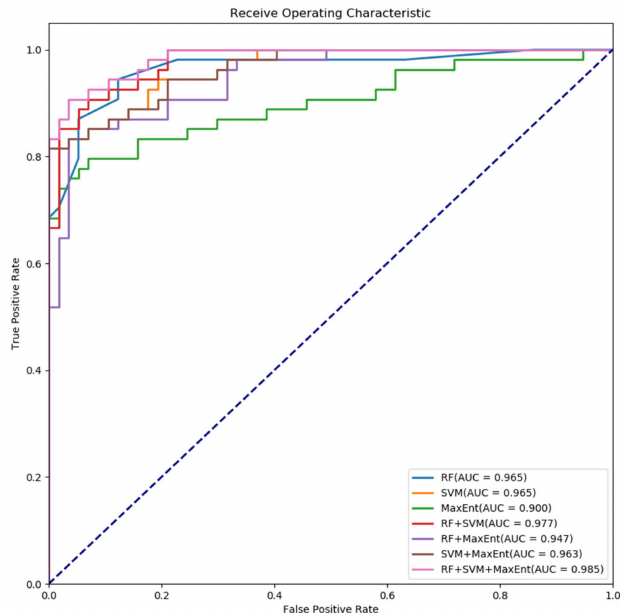
Figure 9. ROC curves and AUC analysis by di ff erent predictive models.